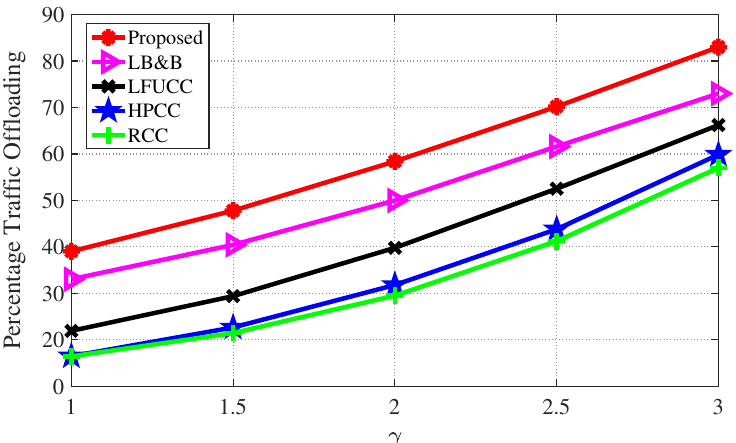
Figure 7. Impact of increasing popularity skewness γ on percentage traffic offloading when N = 50 and F = 400.